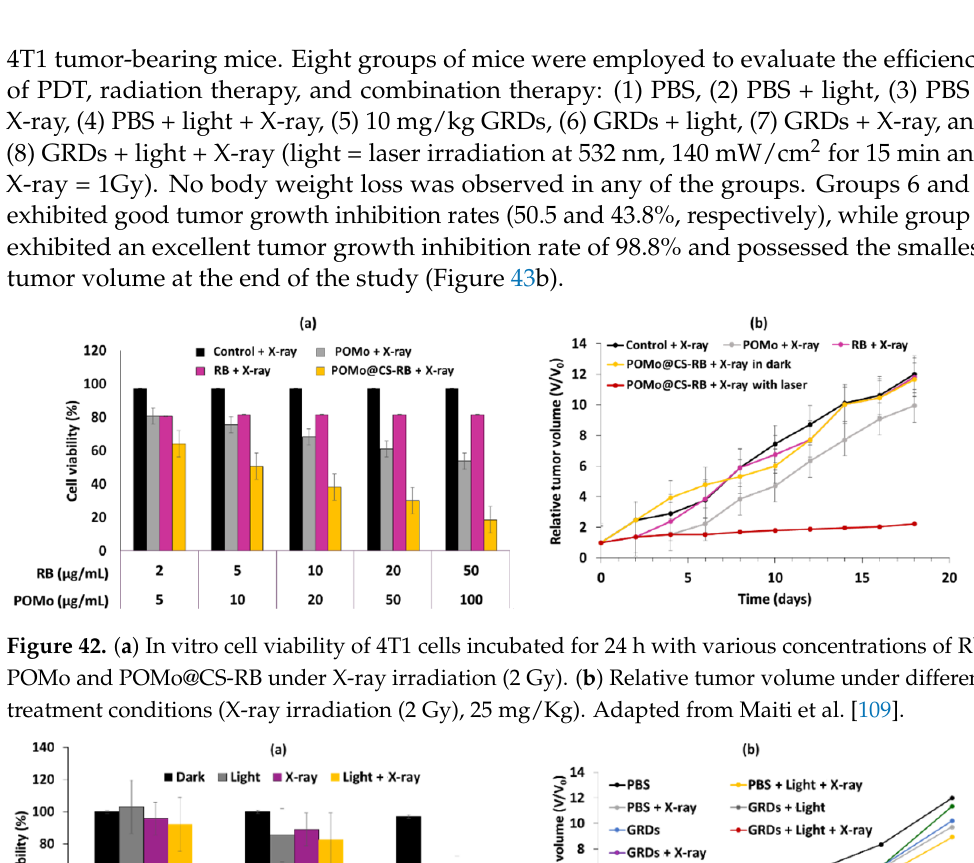
Figure 42. ( a ) In vitro cell viability of 4T1 cells incubated for 24 h with various concentrations of RB,